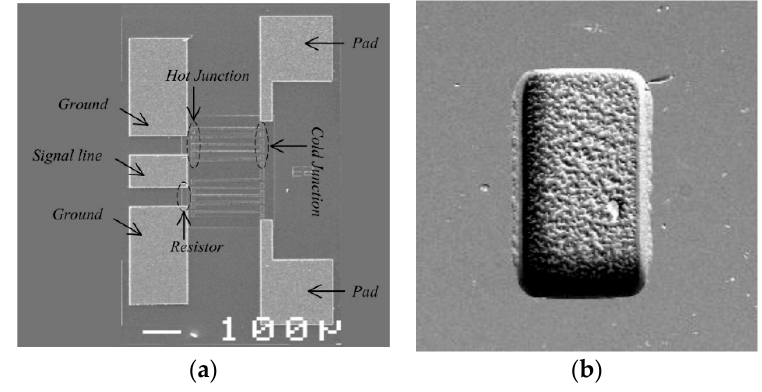
Figure 9. SEM photograph of ( a ) the power sensor and ( b ) the hole underneath the thermopiles.